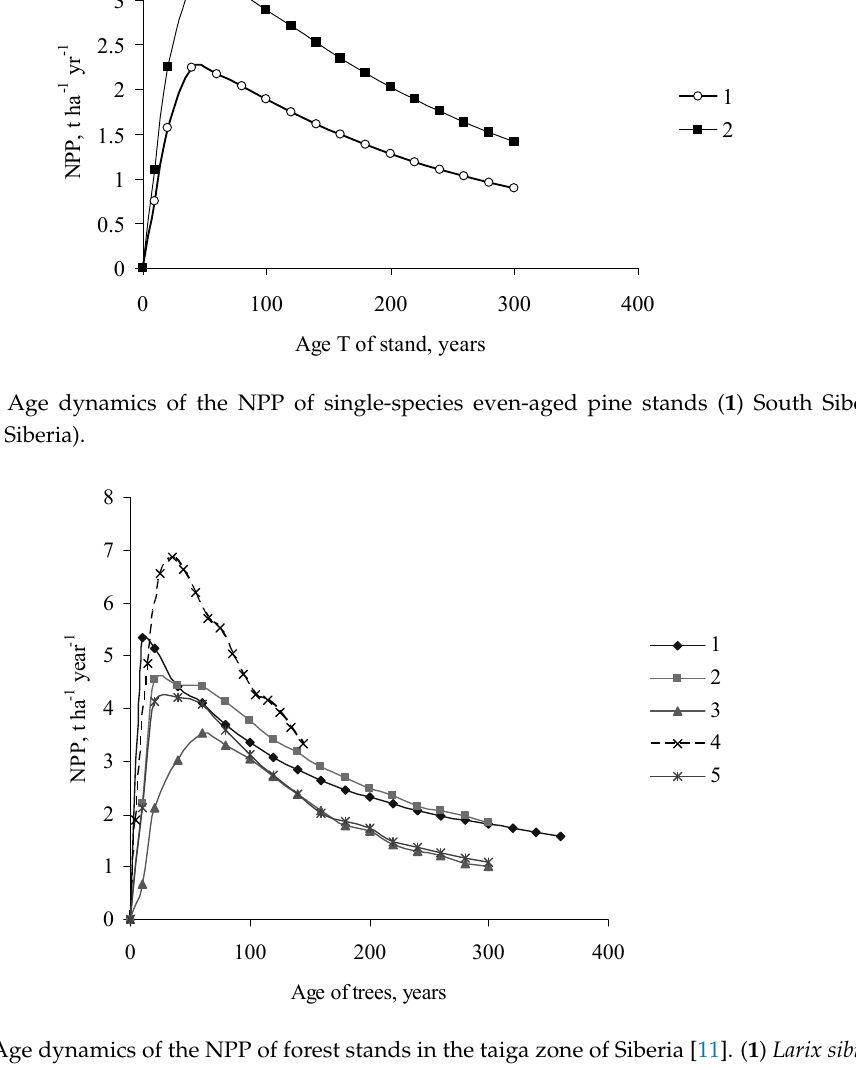
Figure 5. Age dynamics of the NPP of forest stands in the taiga zone of Siberia [11]. ( 1 ) Larix sibirica Ledeb.; ( 2 ) Abies sibirica Ledeb.; ( 3 ) Picea obovata Ledeb.; ( 4 ) Betula pendula Rotsch.; ( 5 ) Pinus sylvestris L.